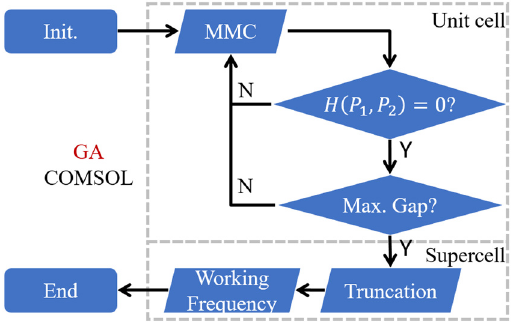
10 − 5 . Some representative iteration histories of the design process are illustrated in Figure A2.